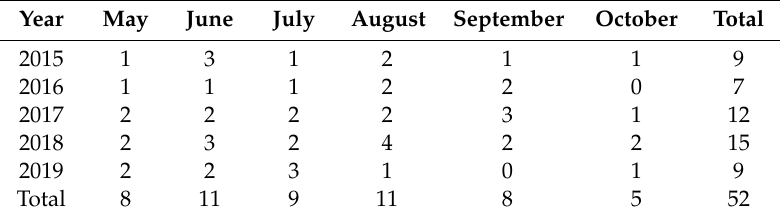
Table 1. The number of Sentinel-1 backscatter coe ffi cient images acquired for the China’s Momoge National Nature Reserve from 2015 to